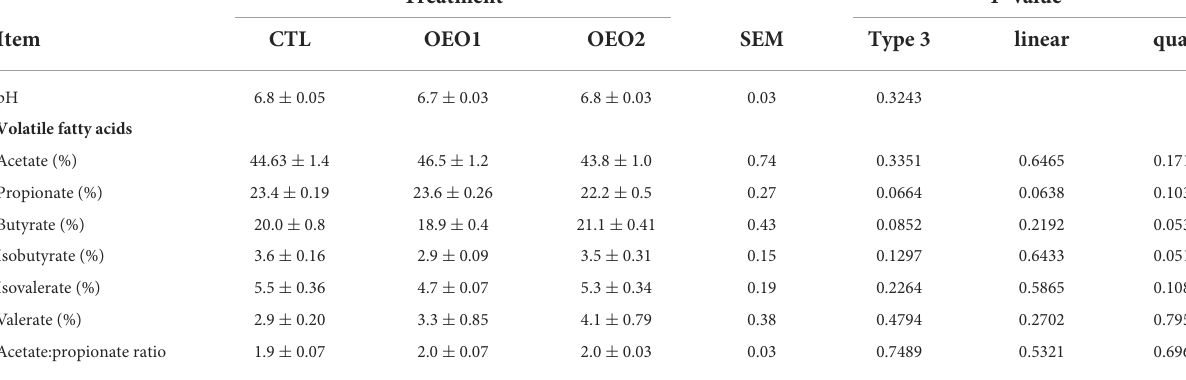
TABLE 3 Effect of orange essential oil (OEO) on pH and volatile fatty acids in vitro ( n = 6). Treatment P -value